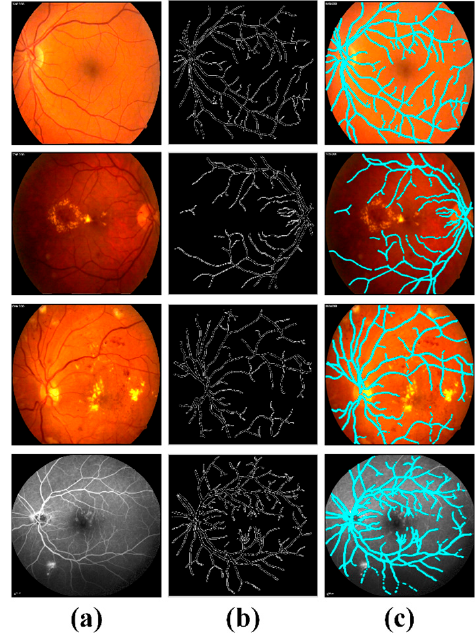
Figure 11. Extracted blood vessels through the proposed system in the [37,41] datasets. ( a ) Original fundus / FA scans; ( b ) extracted blood vessels through proposed system and ( c ) overlaid blood vessels on original fundus / FA